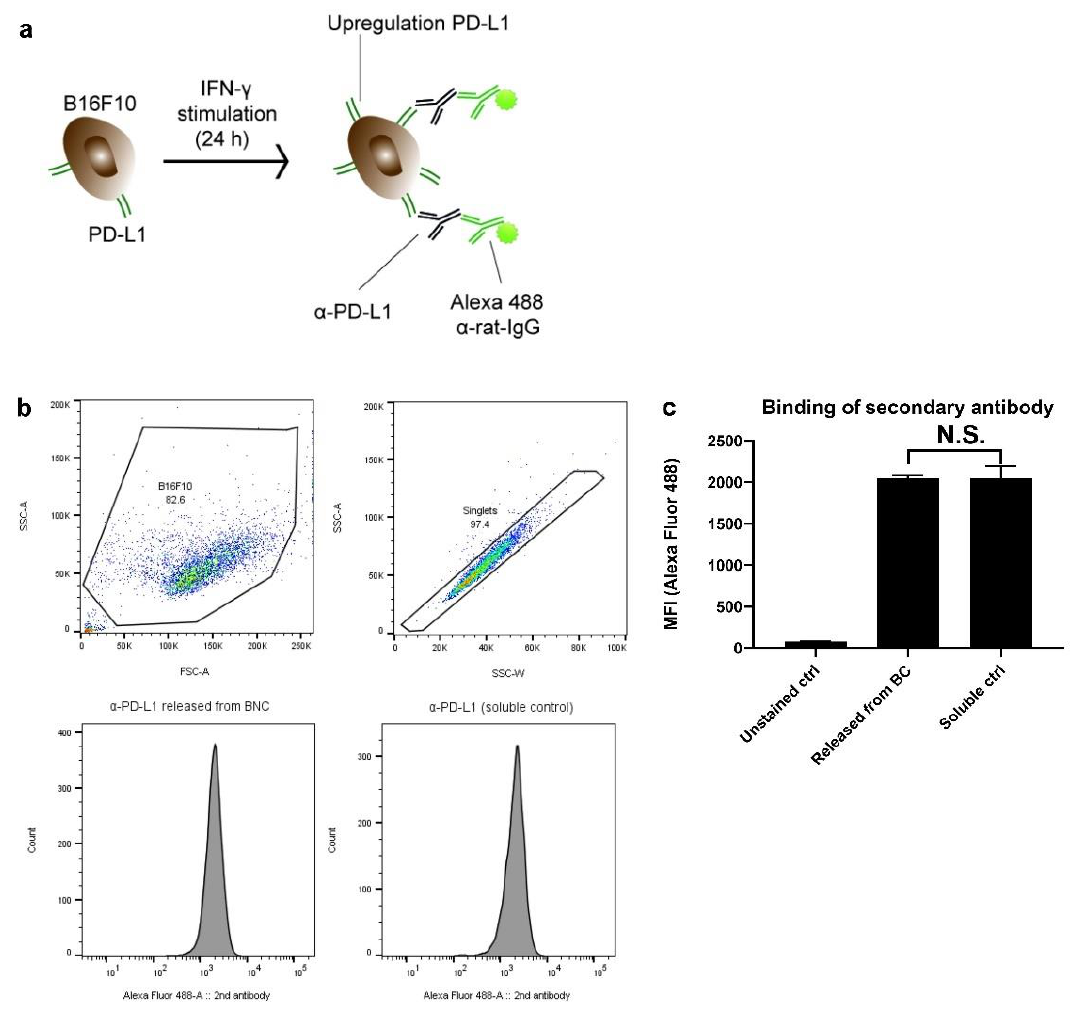
Figure 5. BC does not affect anti-PD-L1 binding capacity to B16F10 cells. In total, 50 µ g of anti-PD-L1 in 25 µ L PBS was injected in a BC fleece. After 7 d, the released antibodies from the BC were harvested to assess the binding capacity. B16F10 cells were incubated 24 h with 10 IU/mL IFN- γ to upregulate PD-L1 expression. Thereafter, the cells were harvested, washed and incubated with the anti-PD-L1 that was released from the BC samples. In the subsequent step, cells were stained with fluorescent labeled anti-rat IgG (Alexa 488 donkey-anti-rat IgG) ( a ). Alexa 488 fluorescence was a measure for PD-L1 binding. This was compared with cells to which stock (fresh) of anti-PD-L1 antibody was added (‘soluble control’). In ( b ), the gating strategy and representative histograms with the Alexa 488 emission peaks are displayed, with the quantification of the mean fluorescent index (MFI) depicted in ( c ). In ( c ), data are shown as mean ± SD for a triplicate measurement, with differences being assessed with Student’s t test and N.S. denoting ‘not significant’.